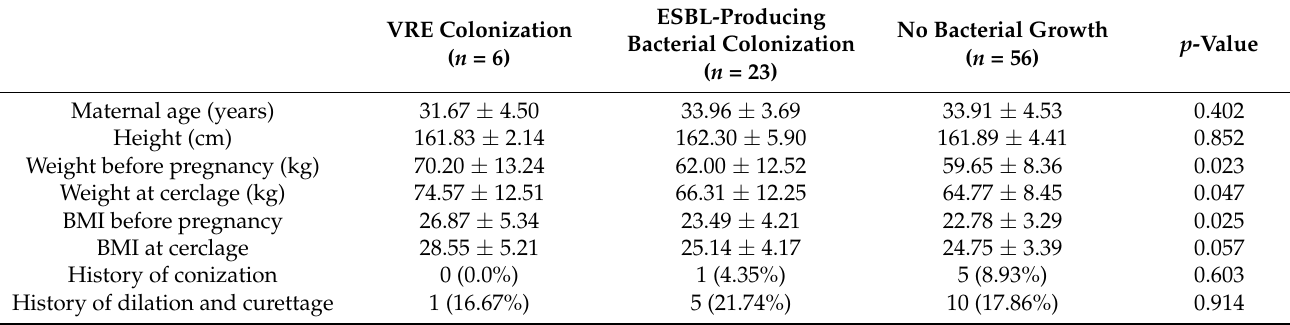
Table 1. Basic characteristics of patients who underwent emergency